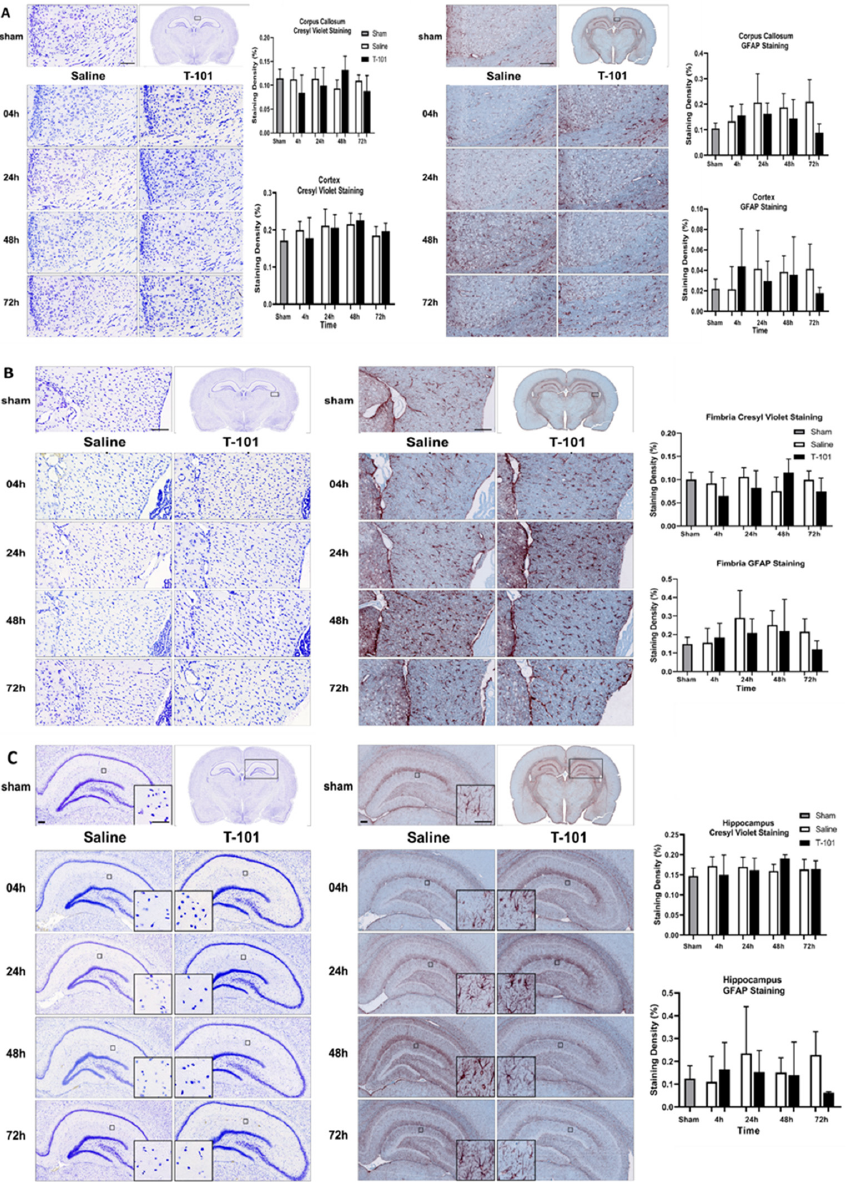
Figure 6. Brain immunohistochemistry. The ( A ) corpus callosum and cortex, ( B ) fimbria, and ( C ) hippocampus were stained with Cresyl Violet (left) for the Nissl substance in neurons and glial fibrillary acidic protein (GFAP) (right) for astrocytes. Data are plotted as the mean ± standard deviation; no significant differences between the SHAM and injury groups. Scale bar equals 100 µm. the analyzed groups included three animals per timepoint for the control and T-101 resuscitative fluid groups, and three animals were analyzed in the sham group.